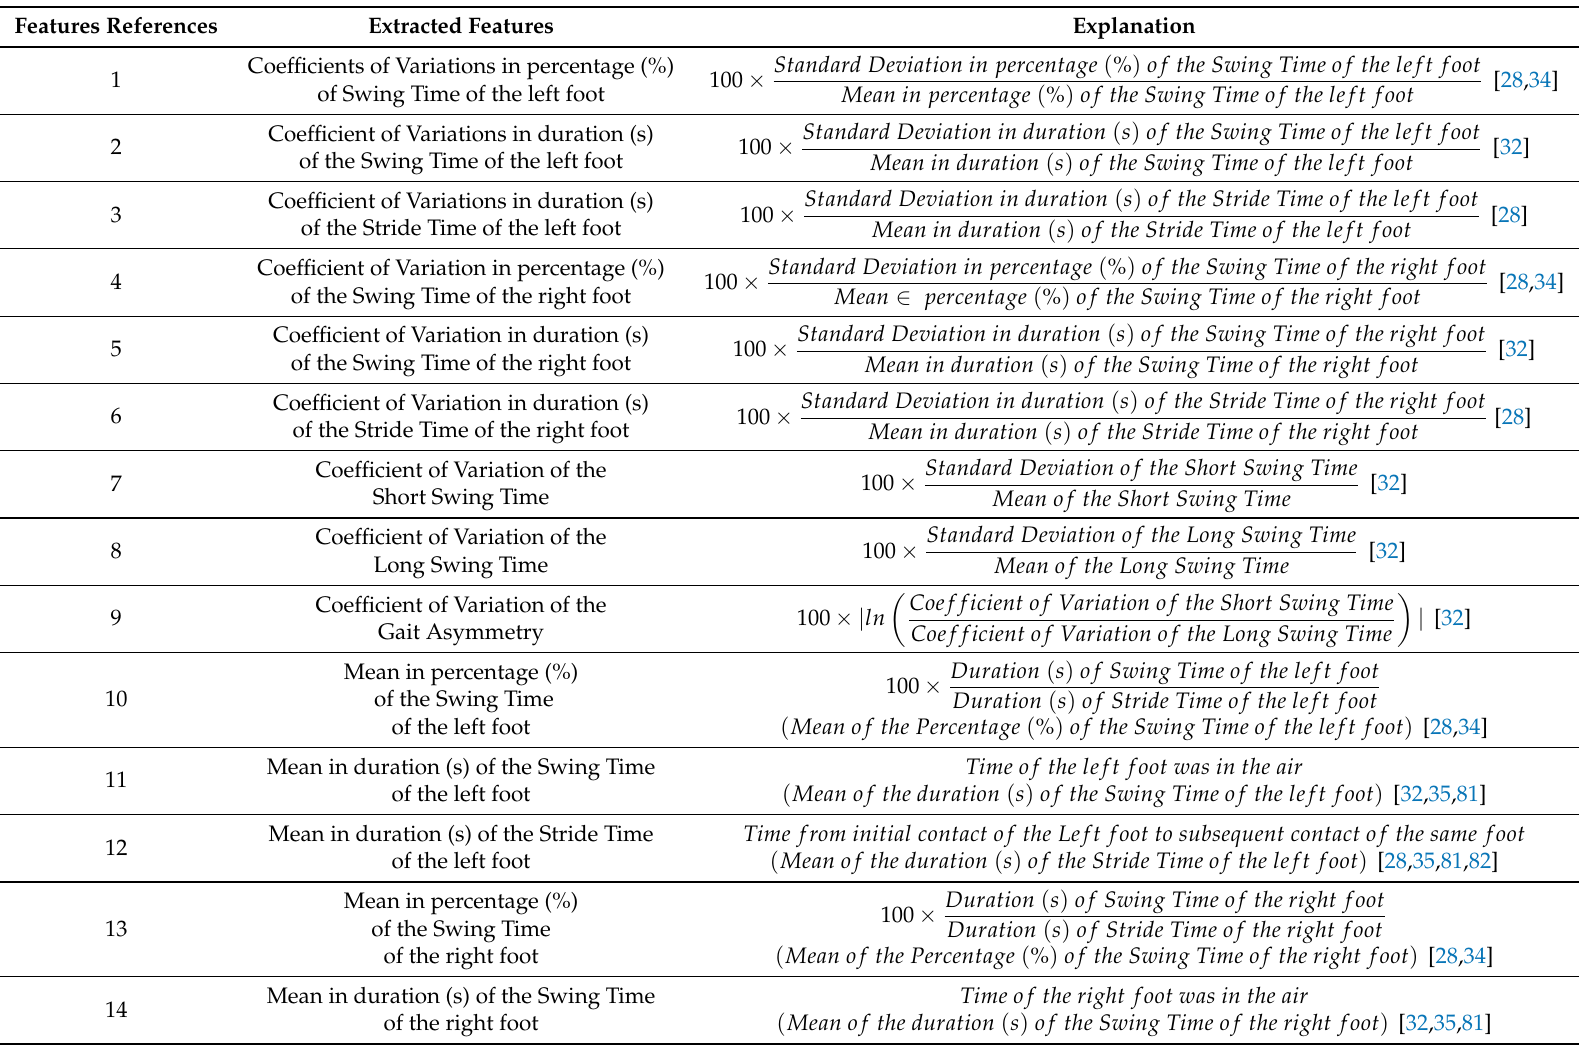
Table 2. List of the nineteen extracted